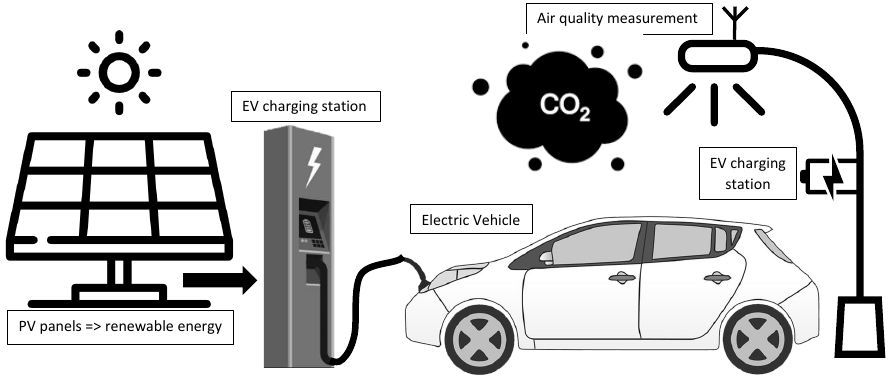
Figure 2. Application of